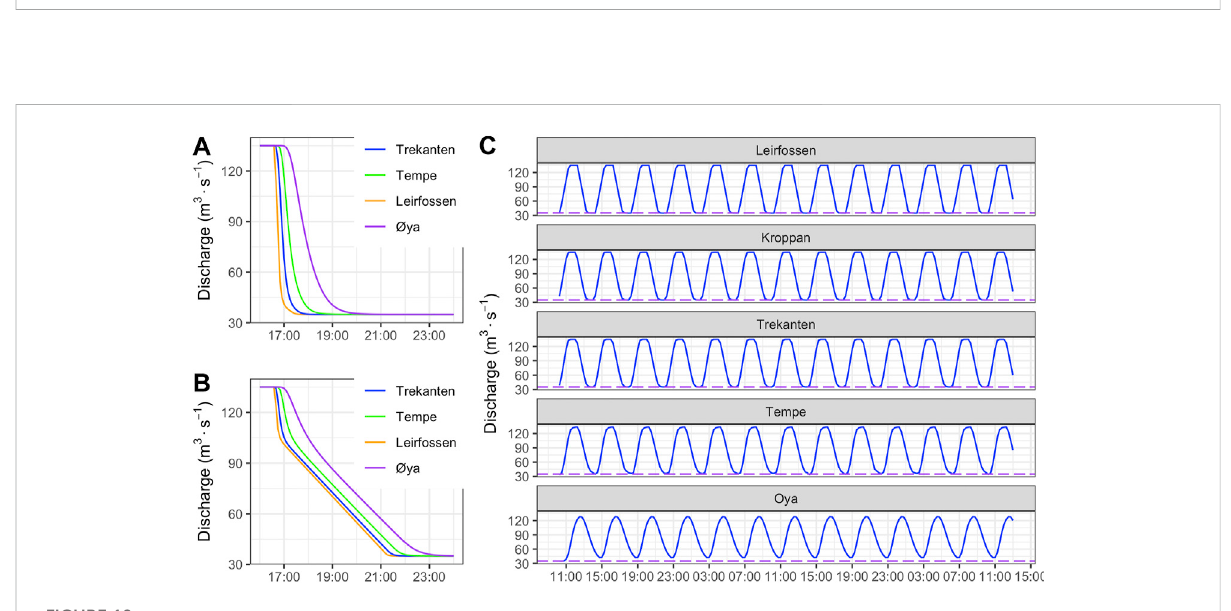
FIGURE 10 Hydrograph propagation. Panel (A) standard hydrograph; Panel (B) mitigated hydrograph; Panel (C) example of frequent start – stop hydrographs with propagation downstream from Leirfossen. The dashed line in panel C shows the level of minimum fl